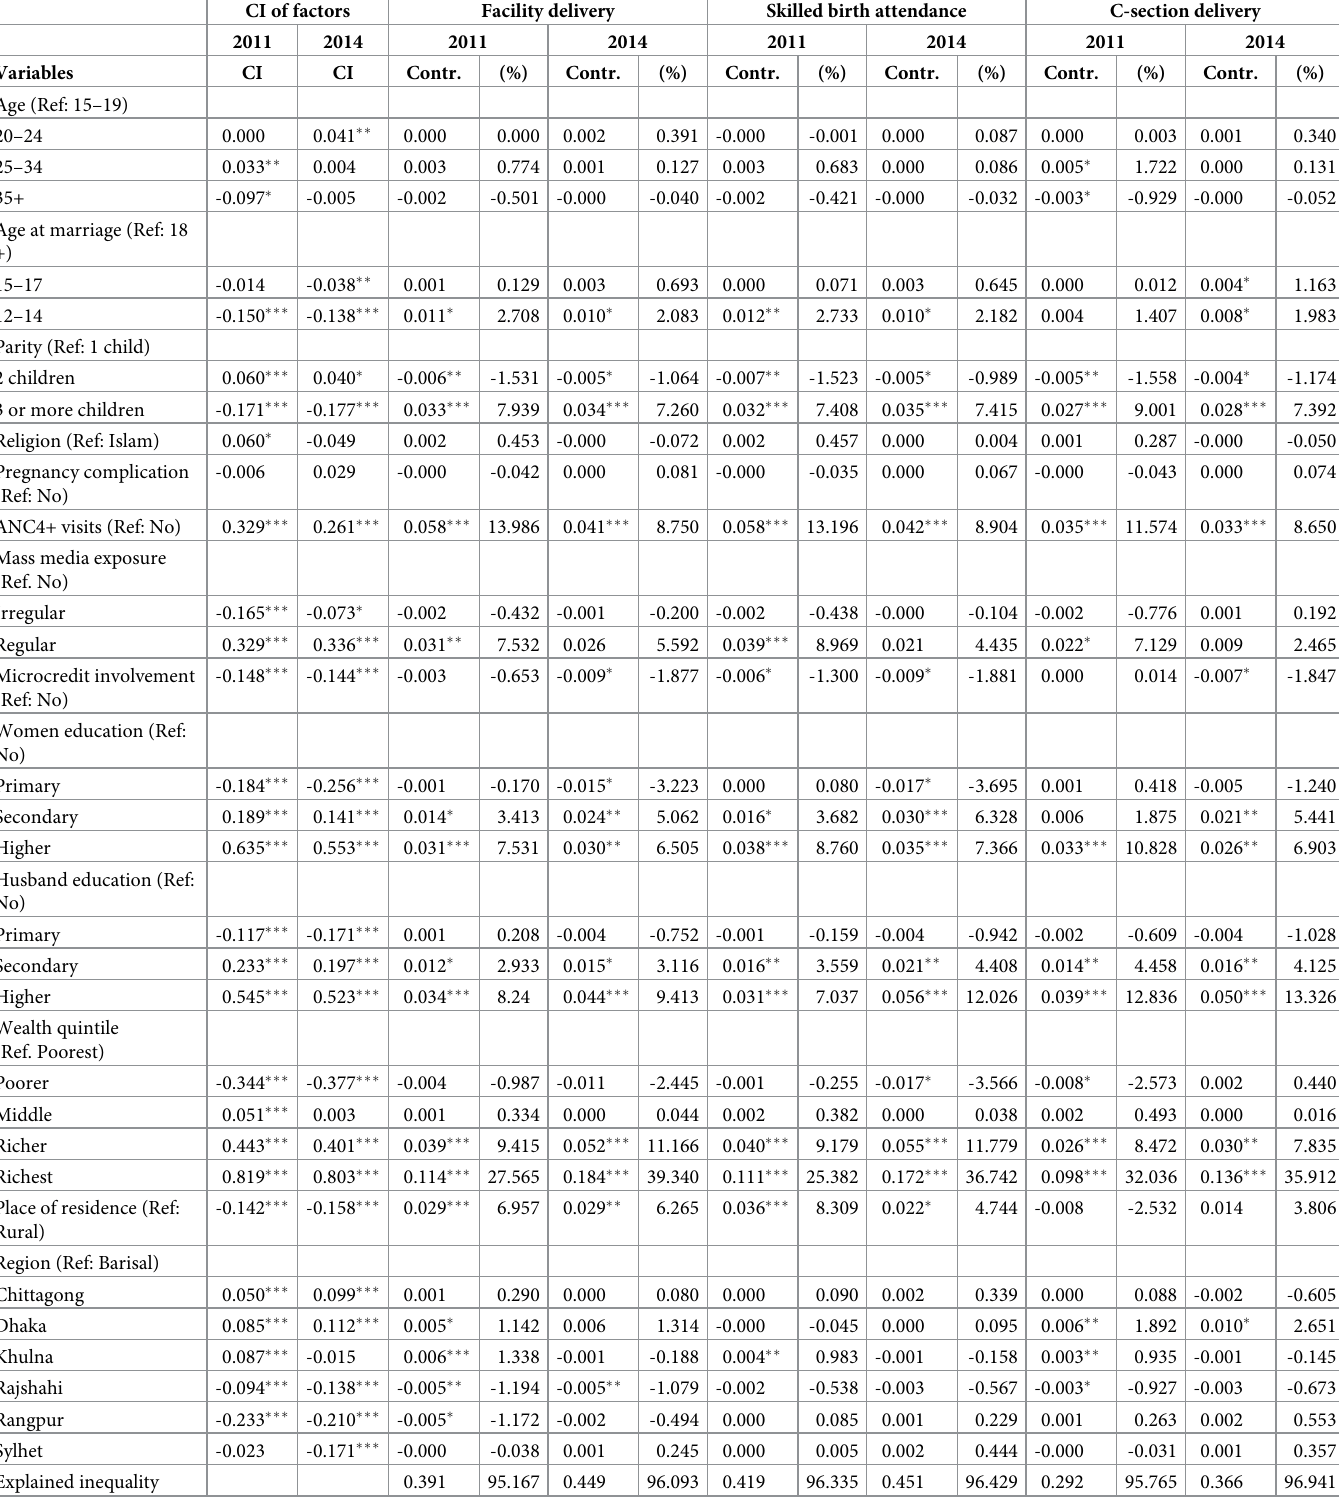
Table 4. Factor contributions to wealth-related inequalities in the use of delivery care services (decomposition of the